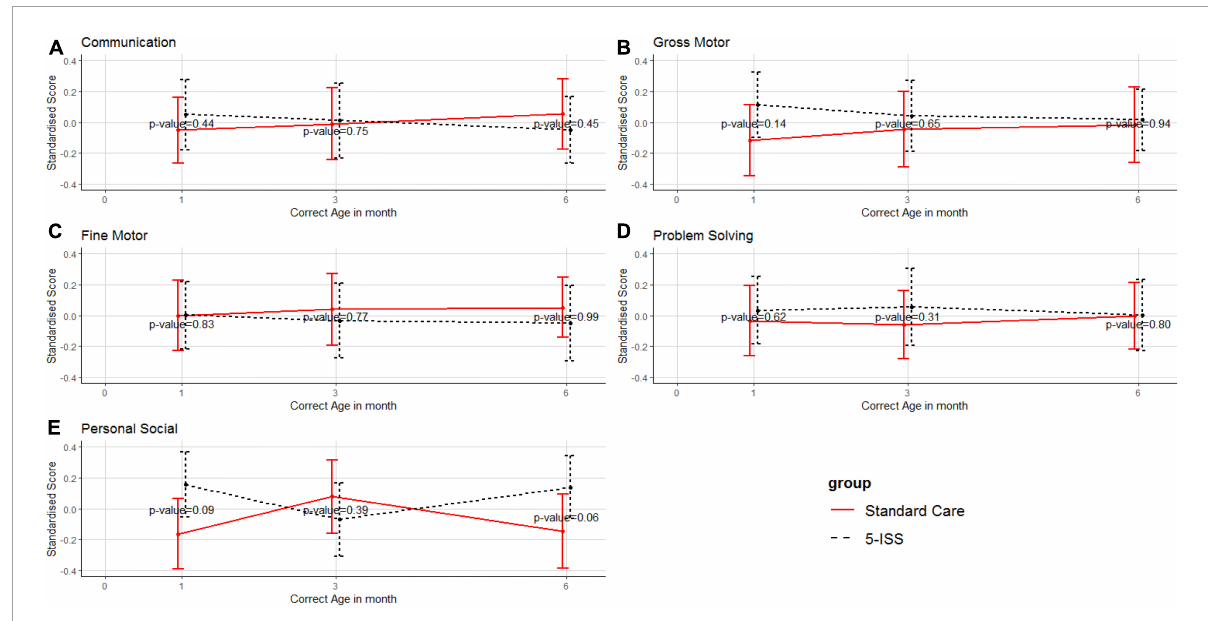
FIGURE3 Mean and 95% confidence interval of standardized scores of communication (A) , gross motor skills (B) , fine motor skills (C) , problem solving (D) , and personal-social (E) between the intervention and standard care groups. Higher scores reflect better neurodevelopmental